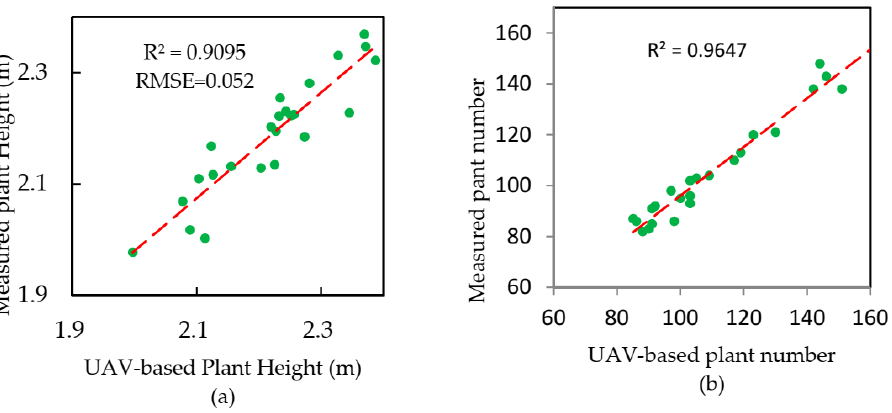
Figure 4. Precision analysis of the unmanned aerial vehicle (UAV)-based data. ( a ) Precision analysis of the UAV-based plant heights and ( b ) precision analysis of the UAV-based lant numbers.